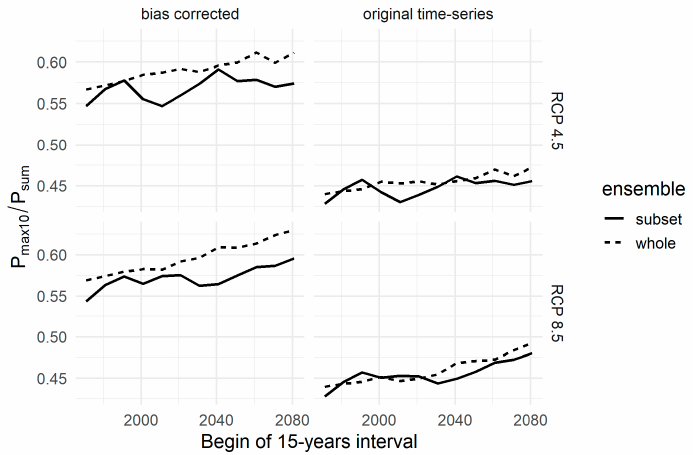
Figure 12. Decadal change in the ratio of P max10 and P sum as derived from Figure 7.